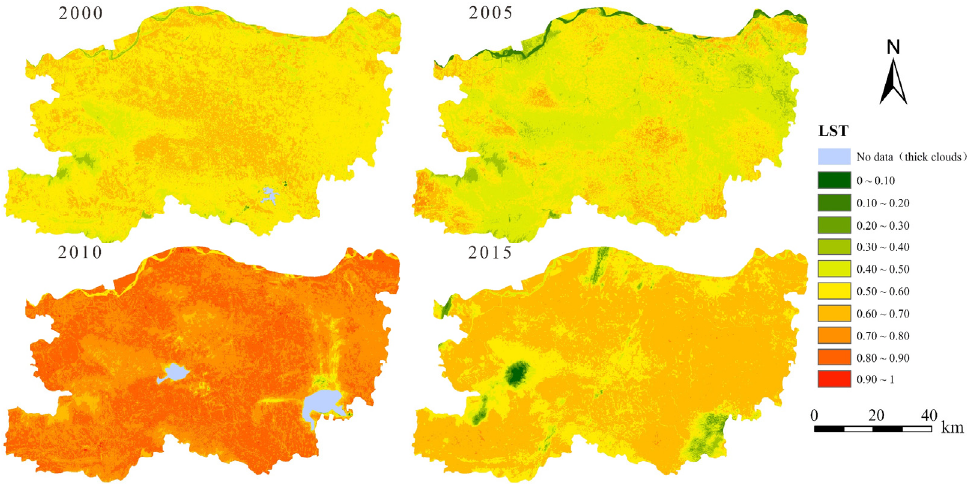
Figure 5. Spatial distribution of LST during the different periods from 2000 to 2015.